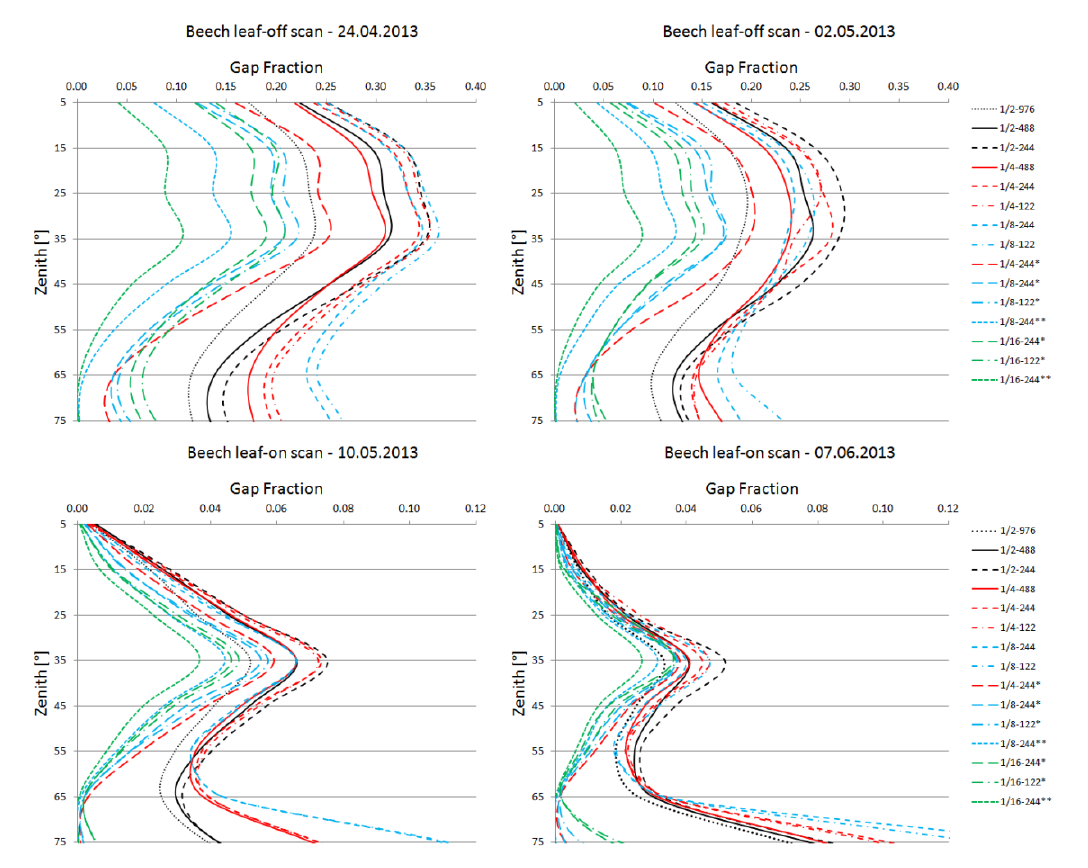
Figure 6. Average gap fractions of the scans collected at the Beech plot with different scan parameters. Legend (scan parameters): Scan resolution is displayed as the fraction of the maximum scan resolution. Scan speed is displayed in kpts/s. The single and double asterisks denote scans performed with the 2-factor and 4-factor noise